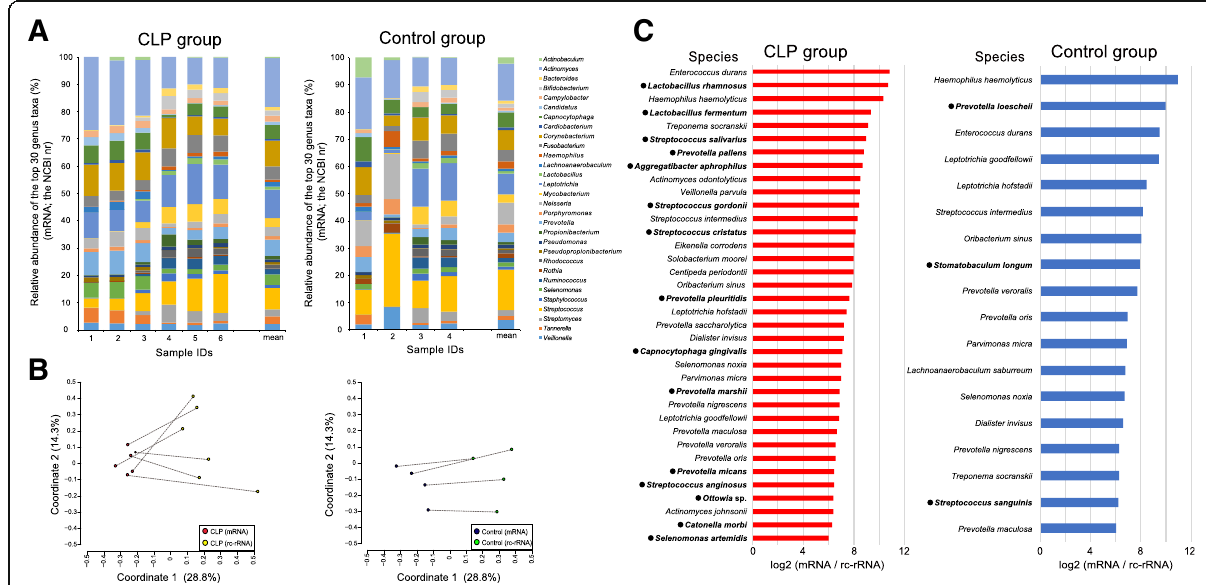
Fig. 3 Bacterial composition estimated from mRNA reads and comparative analysis of 16S rRNA-based and mRNA-based profiles. a In the bar charts, bacterial composition assigned using the NCBI nr at the genus level is presented as the relative abundance. Each color corresponds to a genus on the right side. b For the bacterial composition assigned with the HOMD for rc-rRNA and NCBI nr for mRNA reads, first coordinates in the PCoA are plotted with second coordinates in scatter graphs. For CLP subjects (on the left side), the rc-rRNA-based and mRNA-based compositions are indicated by red and yellow, respectively. For the control participants (on the right side), the rc-rRNA-based and mRNA-based compositions are indicated by blue and green, respectively. c The bar charts show the mean log2 ratio of the active taxa, defined as taxa with a log2 mRNA-to-rRNA ratio of ≥ 6. Group-specific active taxa are indicated by bold characters and filled circles (on the left side of